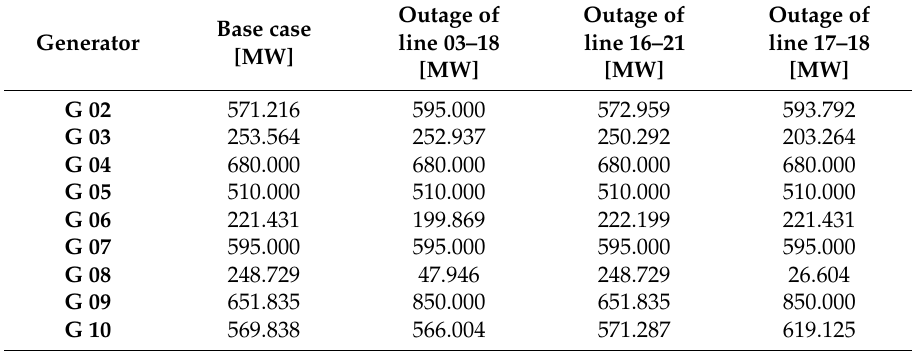
Table 2. Results of the economic re-dispatch after the outage of lines 03–18, 16–21, and